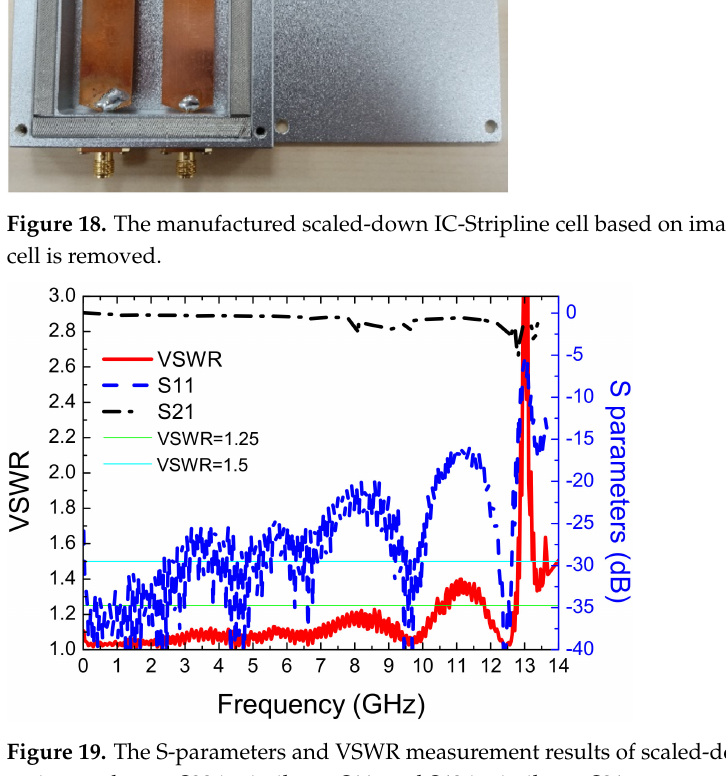
Figure 19. The S-parameters and VSWR measurement results of scaled-down IC-Stripline cell based on image theory. S33 is similar to S11, and S43 is similar to